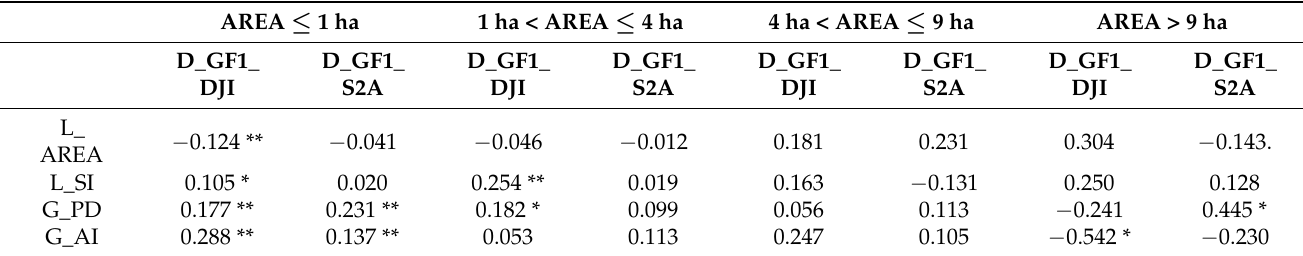
Table 6. The correlations between the influence factors and the differences of GR from data with various